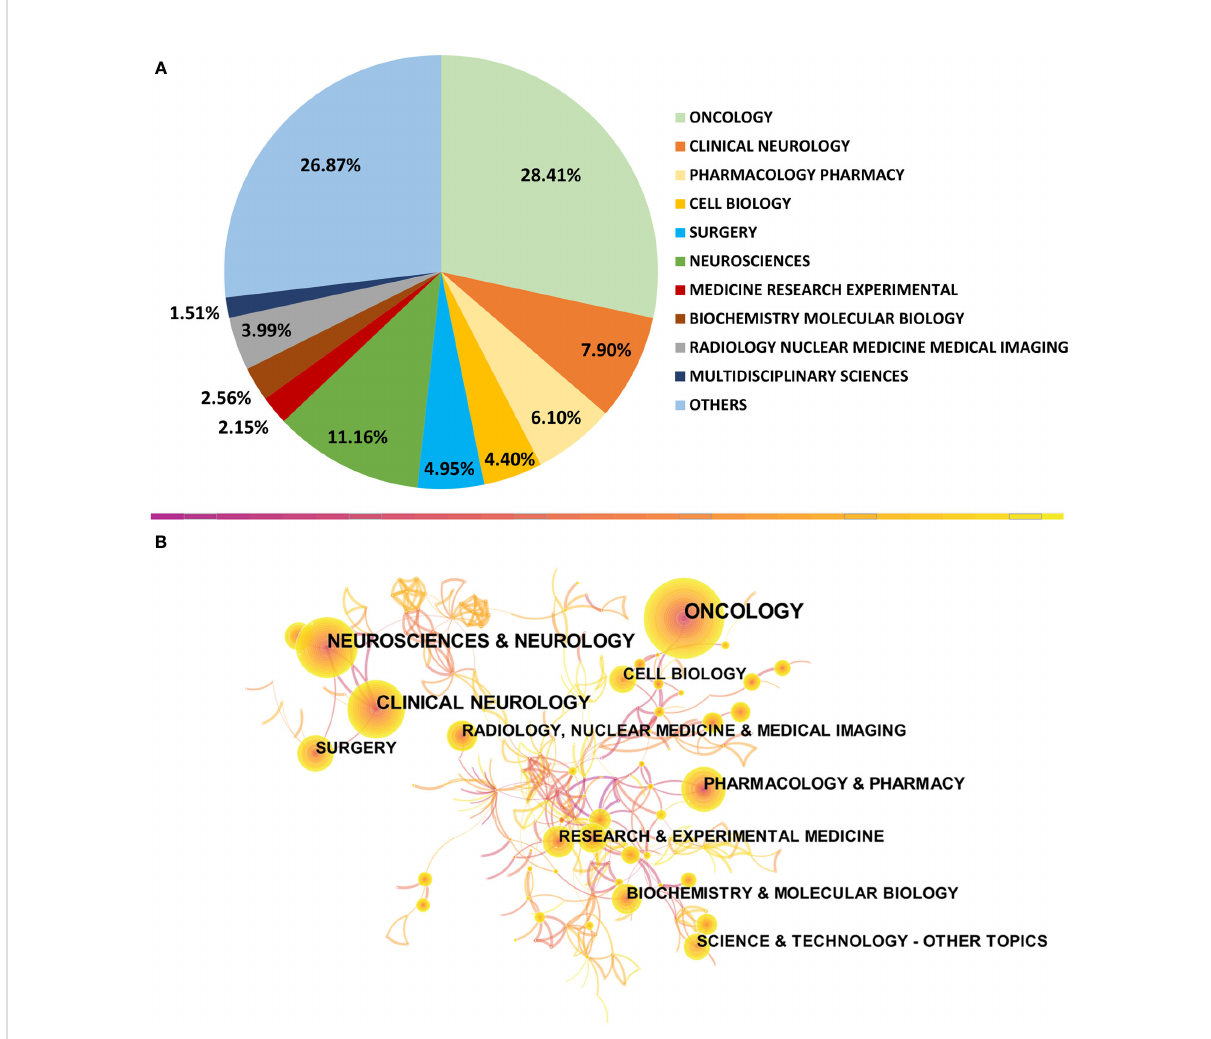
FIGURE 10 Analysis of categories. (A) The top 10 most published subjects within the TMZ area. (B) A category visualization of TMZ research. Each node represents a category, with the node ’ s size representing the frequency of occurrence and the color shade representing the year ’ s distance. The connecting line ’ s thickness between the nodes represents the strength of their interactions, while the connecting lines between the nodes represent their